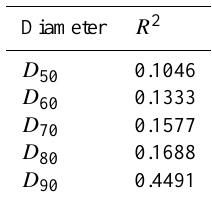
Table 3. Linear regression between different grain sizes and